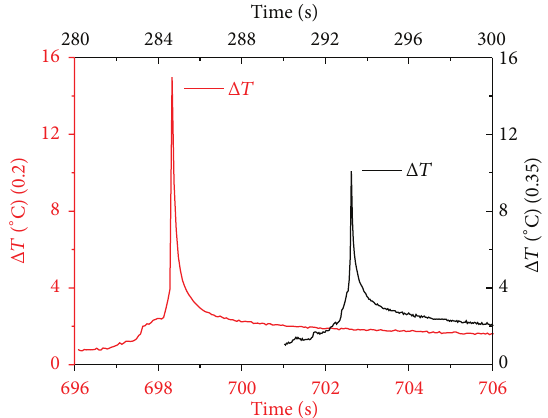
Figure 7: Peak Δ𝑇 for the two notch lengths used in the DEN specimens.